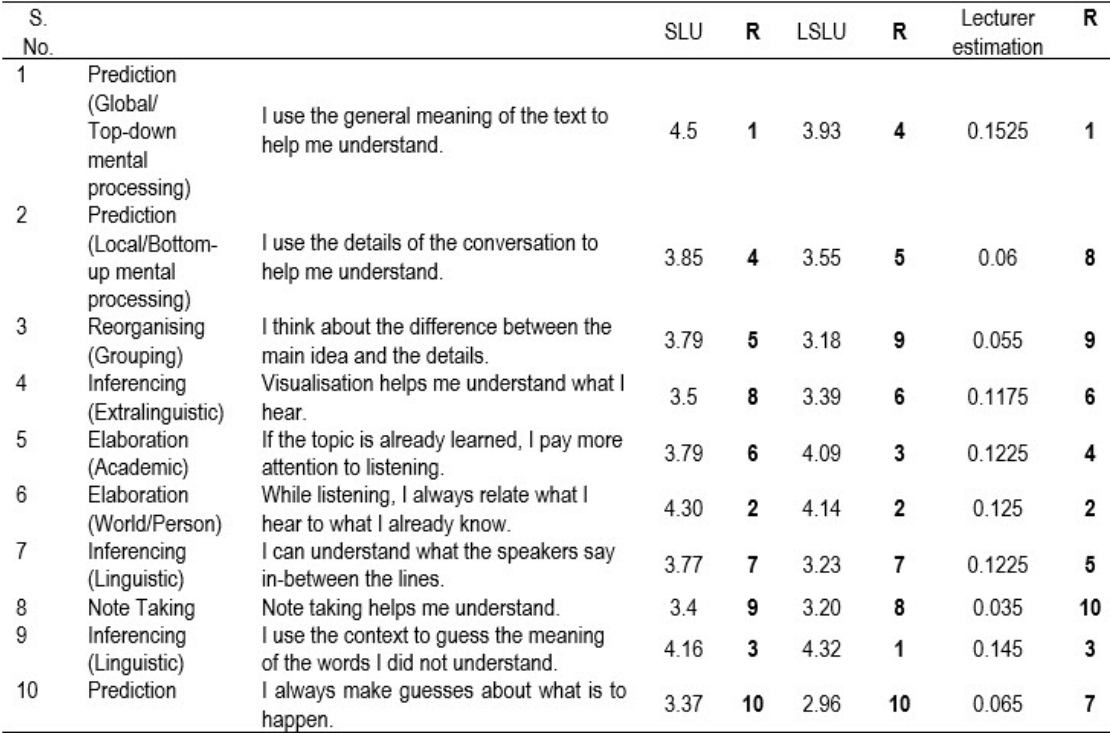
Cognitive strategies - students’ preferences, lecturers’ estimation of the strategy utility and the strategy rank